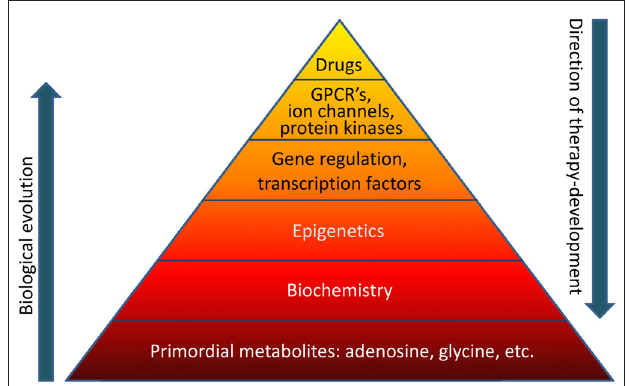
FIGURE 1 | The “pyramid of life”. Evolutionary complexity started with key metabolites and biochemical mechanisms, which form the basis of all forms of life. In contrast, conventional drug development follows a top-down approach. GPCR’s, G protein coupled